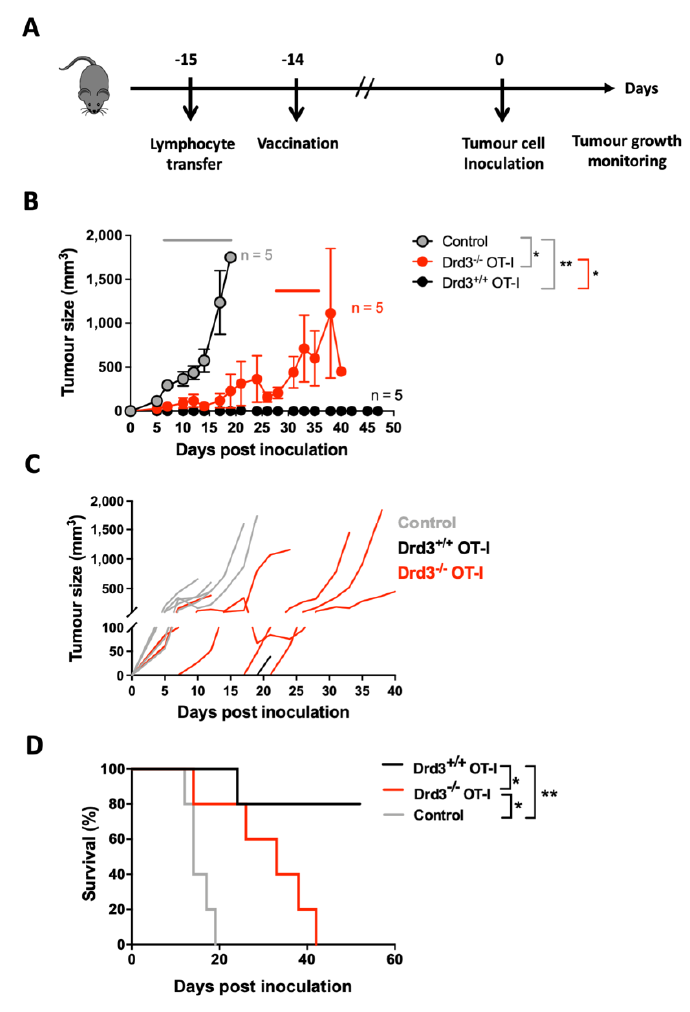
Figure 5. Drd3 -deficient CD8 + T-cells exhibit reduced potency in the anti-tumour response in male mice. Splenic CD8 + T-cells were isolated from Drd3 +/+ or Drd3 − / − OT-I mice, and then i.v. transferred into male C57BL/6 mice (2 × 10 5 cells/mouse). A group of mice did not receive the transfer of exogenous T-cells (Control). One day later, mice received an intradermal vaccination with 40 µ g of pVAX-OVA. Thirteen days after vaccination, mice were s.c. inoculated with B16/OT-I melanoma cells (10 6 cells/mouse), and tumour growth and mice survival were monitored over time. ( A ) The experimental design is illustrated. ( B ) Tumour growth is represented as tumour volume in time. Data are the mean ± SEM from five mice per group. The top grey line indicates the frame of time where significant differences were found compared to the control group, and the red line indicates the frame of time where significant differences were found between mice receiving Drd3 +/+ or Drd3 − / − OT-I cells. ( C ) Tumour growth curves for individual mice are shown. ( D ) Mice’s survival over time is shown. Data from a representative (n = 5 mice per group) of two independent experiments are shown. *, p < 0.05; **, p < 0.01 by two-way ANOVA followed by Tukey’s post hoc test (B, grey line), by multiple t-test (B, red line) or by logrank test ( D ). n.s., not significant.